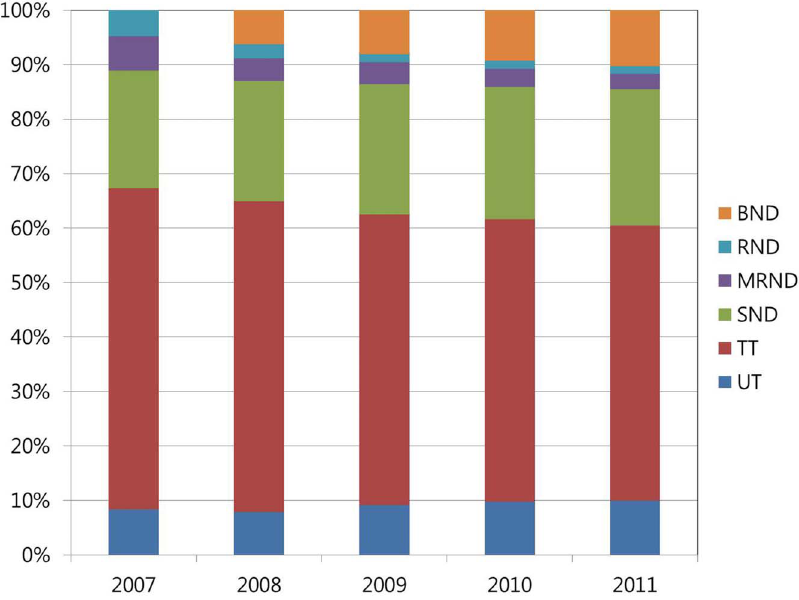
Figure 1. The proportions of thyroid surgeries from 2007 to 2011. The proportion of SND + MRND + RND + BND increased from 32.70% in 2007 to 39.50% in 2011. In contrast, the proportion of UT + TT decreased from 67.30% in 2007 to 60.50% in